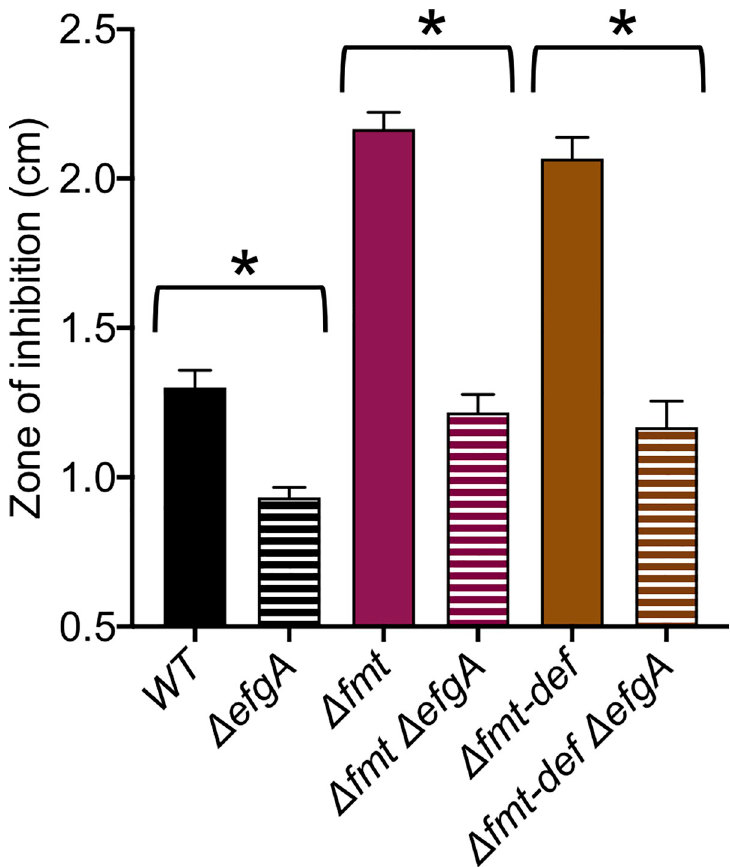
Fig 12. EfgA-mediated formaldehyde resistance is not dependent on PDF. Disc-diffusion assays were performed by placing formaldehyde-impregnated discs upon soft agar overlays of M . extorquens on solid MP media (125 mM methanol). The zones of inhibition observed showed that like wild type, mutants lacking the fMet-mediated protein degradation signal ( Δ fmt , Δ fmt-def ) are more formaldehyde-resistant when efgA is also deleted. Wild-type and Δ efgA mutant were included as experimental controls. Error bars represent the standard error of the mean for three biological replicates. Statistical significance was determined by an unpaired Student t test ( � , p < 0.05). The original data shown in this and all other figures are available in Supporting information file S1